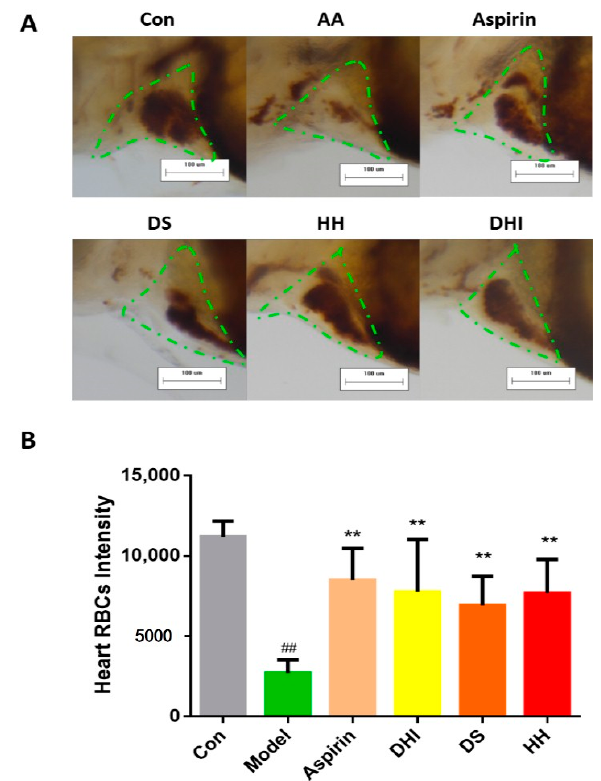
Figure 3. Heart red blood cells (green dashed line) stained with o -dianisidine ( A ) and the heart red blood cell intensity in the zebrafish of the control group, model group (AA 40 μ M), positive drug group (aspirin 22.5 μ g/mL), danshen (DS) group (100 μ L/mL), honghua (HH) group (100 μ L/mL), and danhong group (100 μ L/mL), at a 100× magnification; ( B ) The error bars represent the standard deviation based on ten repeated samples. All data was represented by the mean ± SD, ## p < 0.01, ** p < 0.01, n = 10.